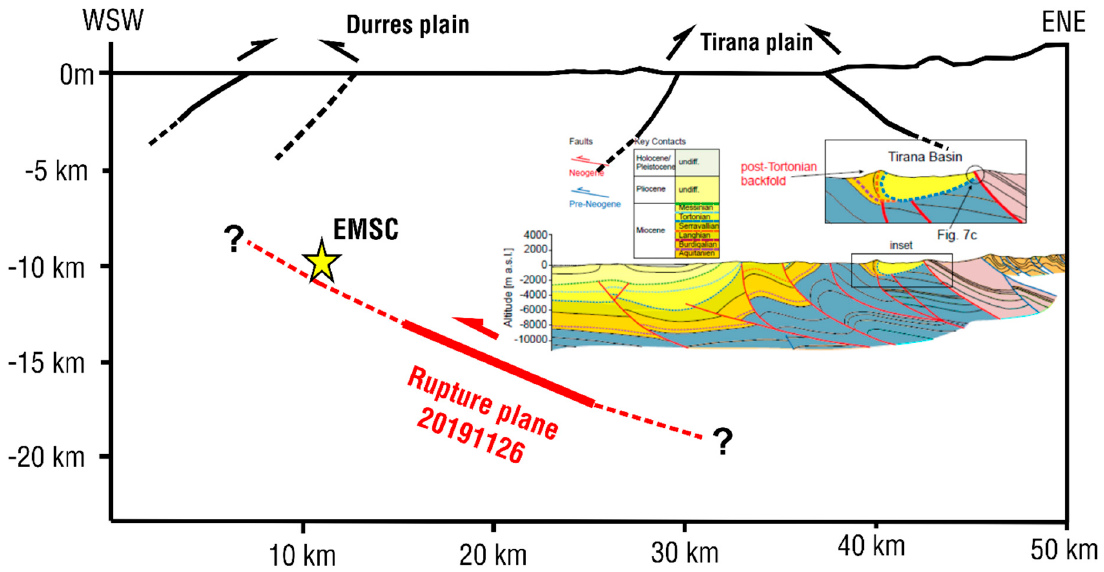
Figure 6. Schematic cross section across the strike of the seismic fault of the November 26, 2019 earthquake. The inferred fault plane is indicated by the red line (half arrow denotes motion of the hanging wall of the fault). Inset profile shows geological structure [8]. No vertical exaggeration. The trace of the section is noted in Figure 1b.